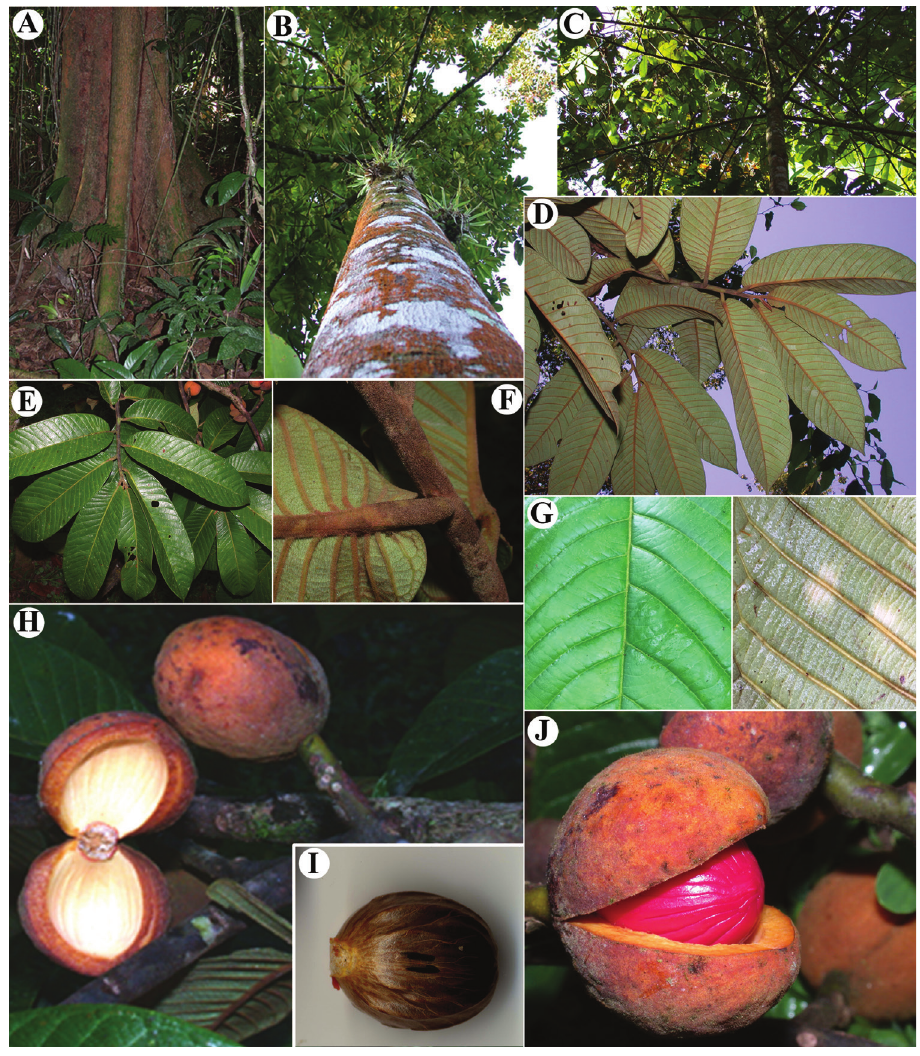
Figure 17. Virola koschnyi A lower trunk and buttresses B trunk C branching D leaf blades on abaxial surface E leaf blades on adaxial surface F twig, petiole and leaf base G leaf venation on adaxial surface (left) and abaxial surface (right) H branch with fruits, showing the interior part of the fruit I seed J ma- ture fruit. All photos by Reinaldo Aguilar from https://sura.ots.ac.cr/florula4/index.php, except G by D.